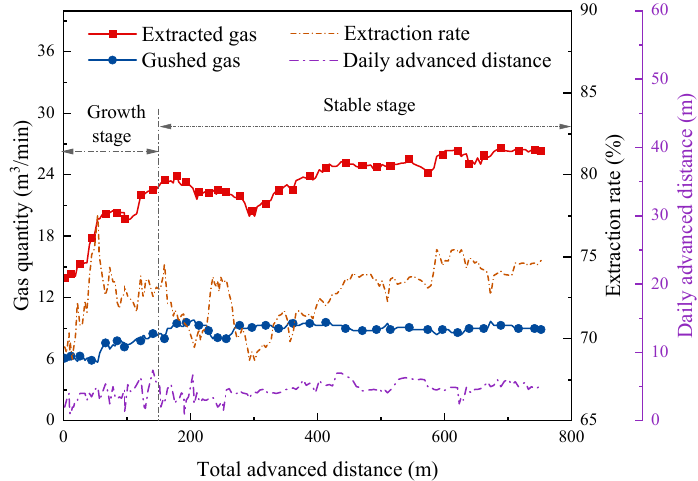
Figure 10. Relationship between working face production and gas drainage.